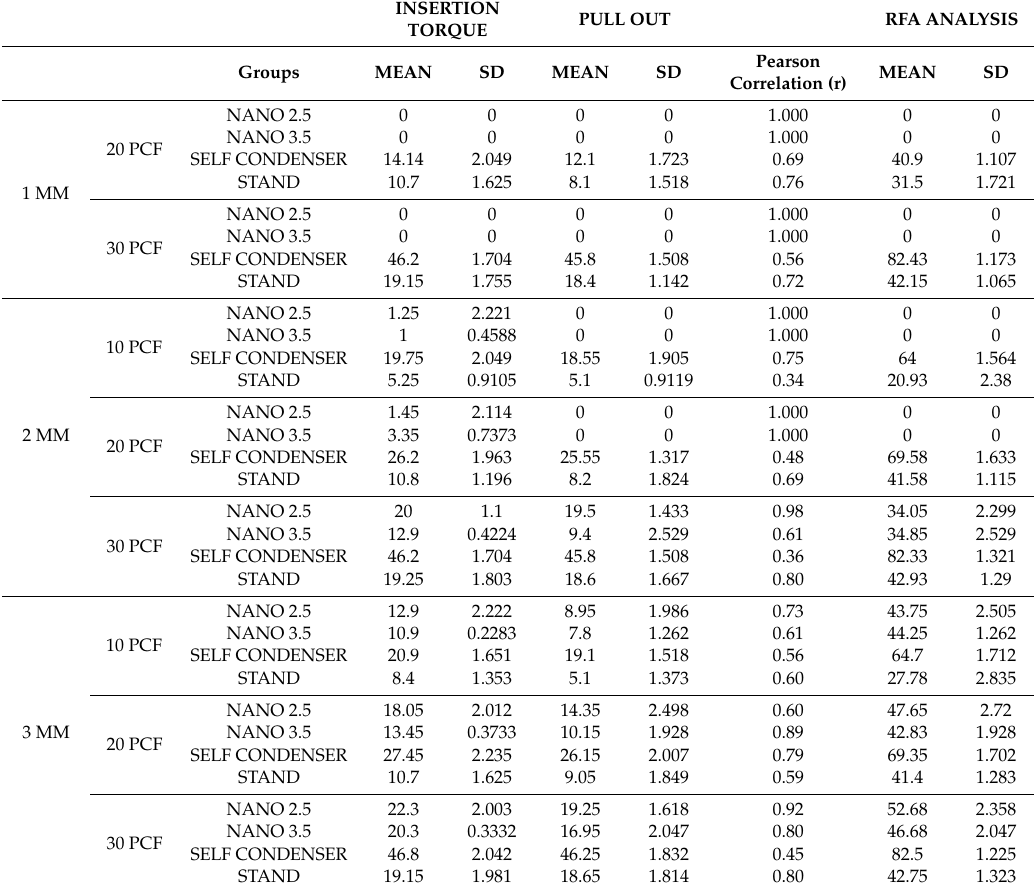
Figure 5. Resonance frequency analysis (RFA) effectiveness of the study groups. Table 1. Values of insertion torque, pull-out strength, and RFA e ff ectiveness of the study